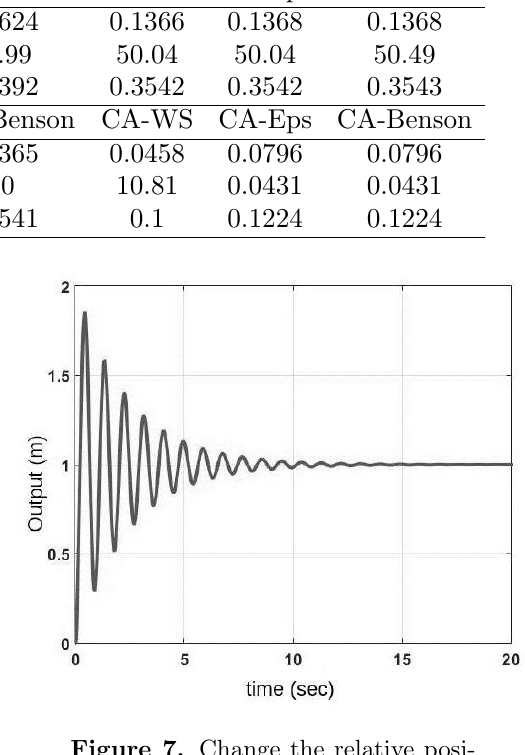
Figure 7. Change the relative posi- tion of the car body without control